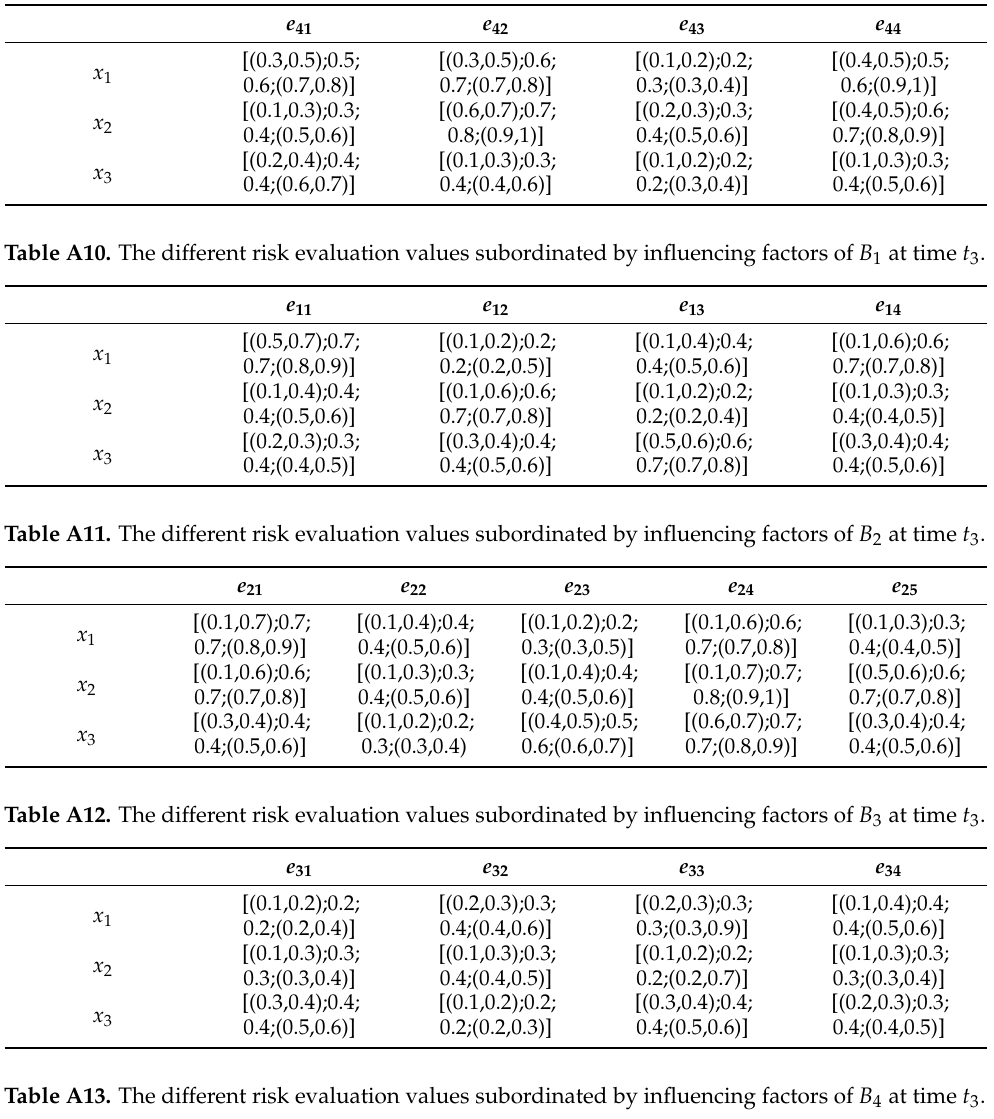
Table A9. The different risk evaluation values subordinated by influencing factors of B 4 at time t 2 .